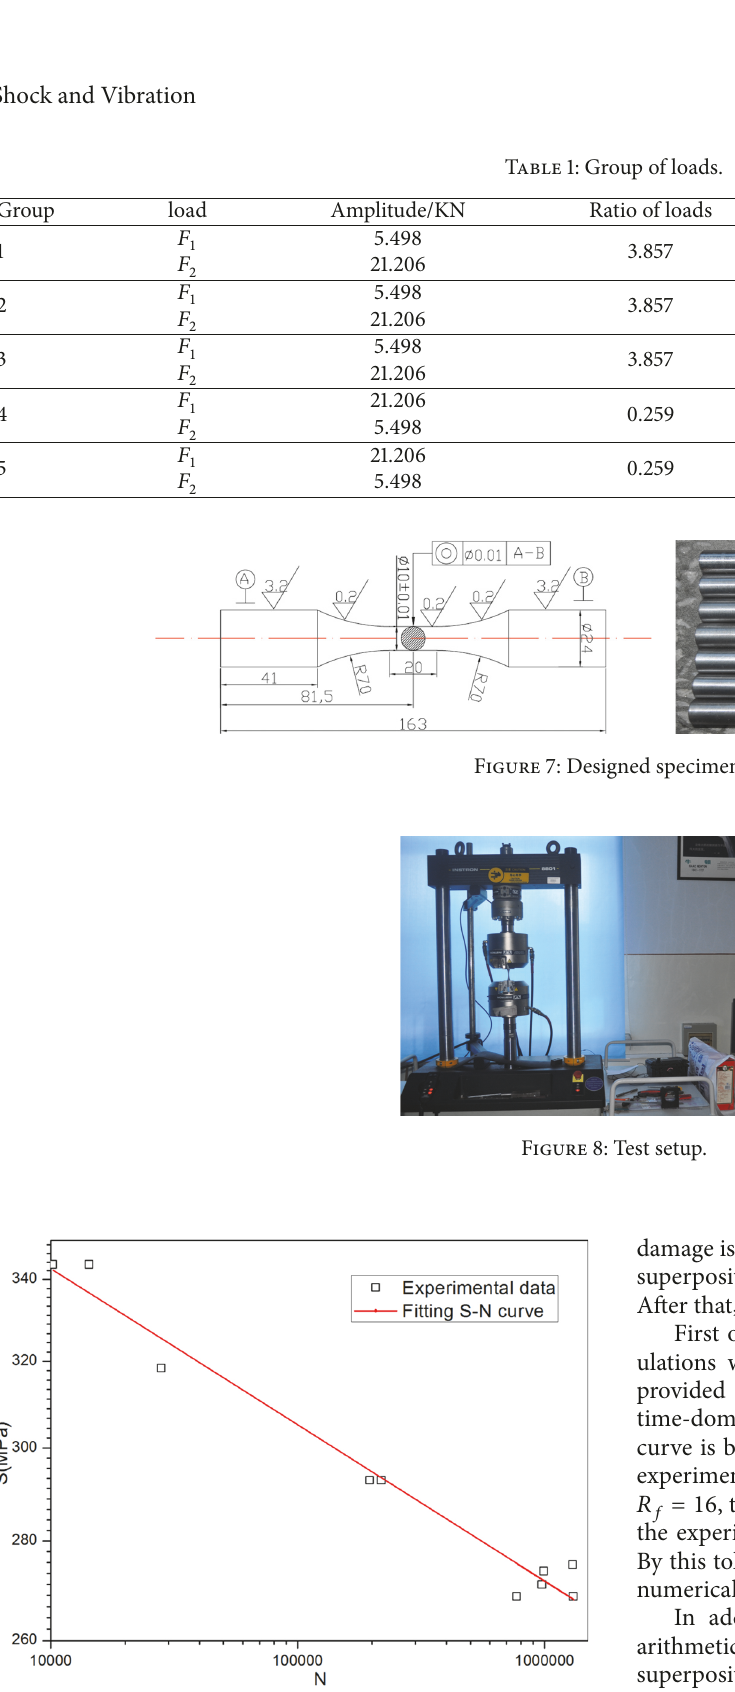
Figure 9: Test data of S - N